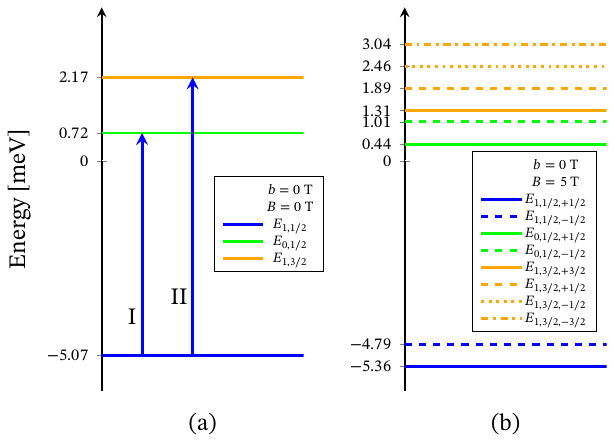
Figure 7. Heisenberg energy spectrum for the polyanion [Er(W 5 O 18 ) 2 ] 9 − , ( a ) in the absence of external magnetic field, ( b ) with applied field. The blue arrows show the two ground state magnetic excitations, see Figure